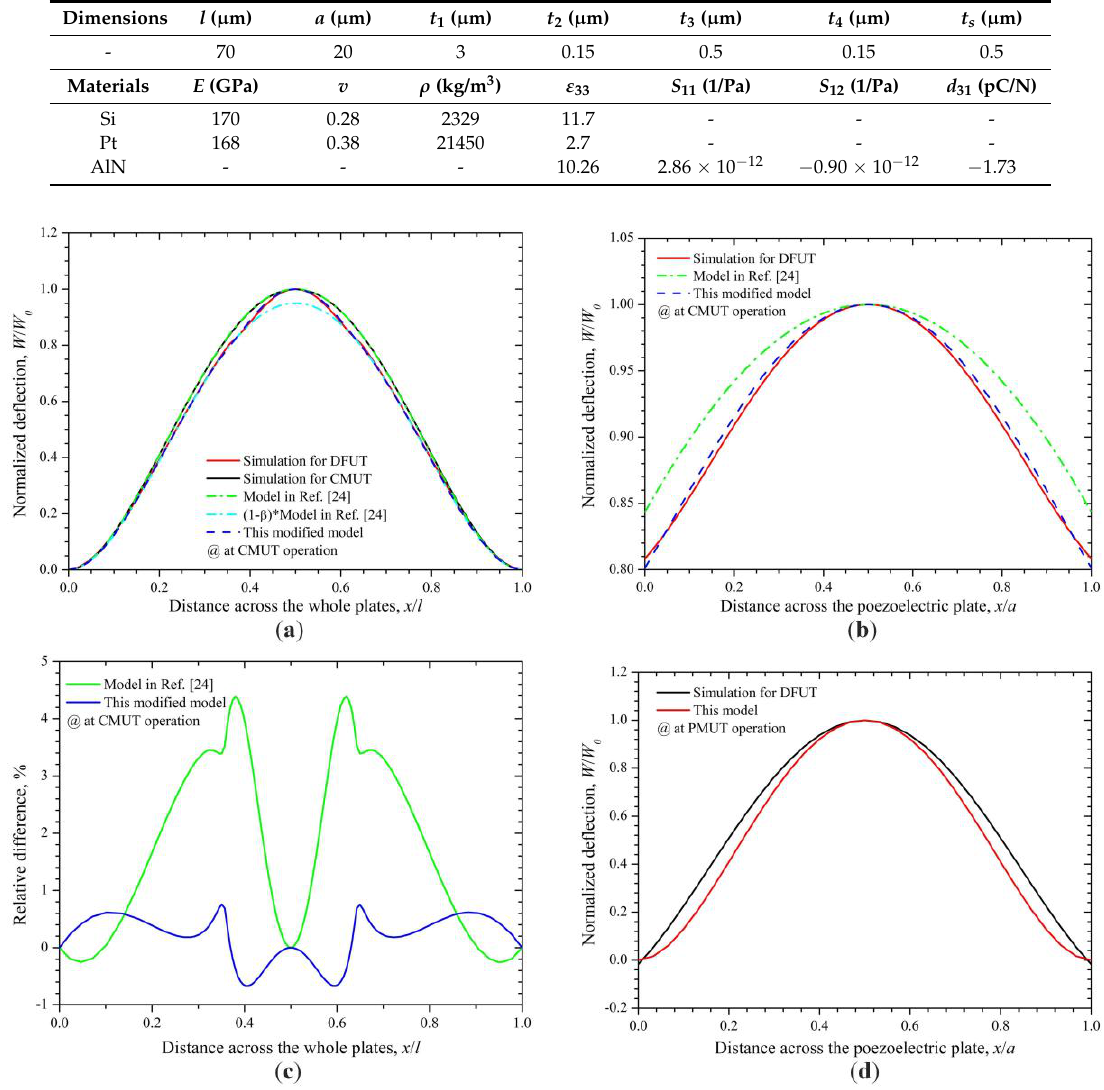
Figure 4. Normalized deflections ( a ) across the whole laminated plates and ( b ) across the piezoelectric plate for CMUT operation; ( c ) relative difference between theoretical calculations and simulations for CMUT operation; ( d ) normalized deflections across the piezoelectric plate for PMUT operation.